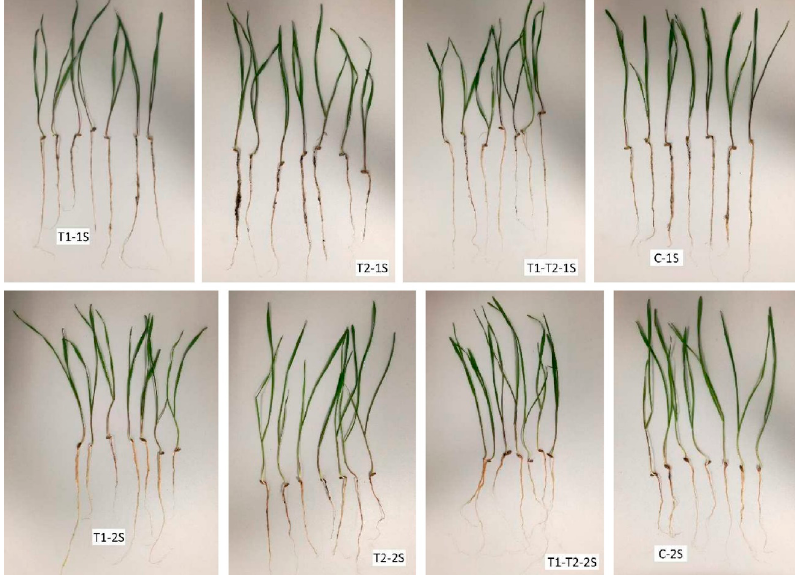
Figure 5. The early seedlings of rye after harvest. T1-1S—grassland inoculated with T. tomentosum , T2-1S—grassland inoculated with T. ghanense , T1-T2-1S—grassland inoculated with the complex T.